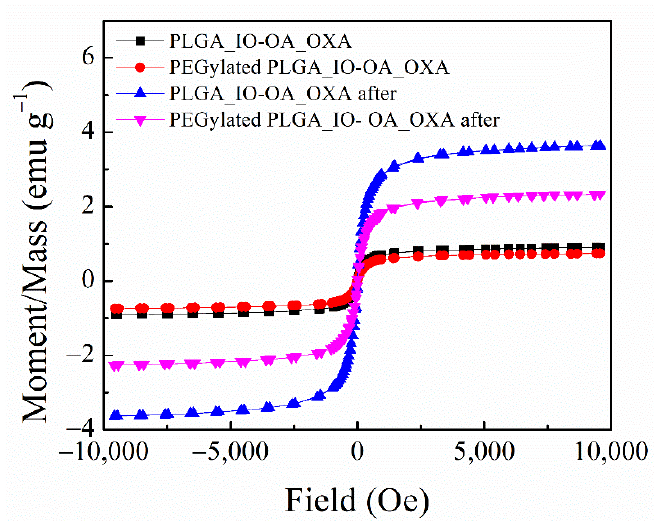
Figure 7. Magnetization curves for the multicomponent PLGA based delivery system (PLGA_IO- OA_OXA) and its PEGylated analog (PEGylated PLGA_IO-OA_OXA) before and after dissolution tests measured at room temperature (25 °C) in the magnetic field from − 10 kOe to +10 kOe.